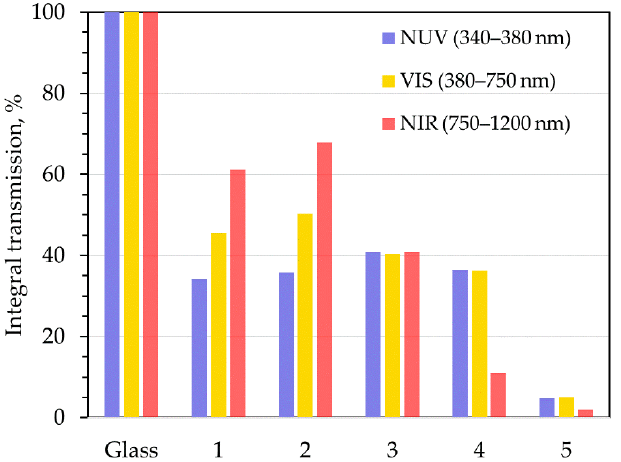
Figure 8. Normalized integral transmission of the valve metals functional thin films. On average, the transmission attenuation for quasi-ordered samples 1–4 in the ranges studied is about 40–60%. The best transmittance is recorded in the NIR range for anodic aluminum films containing a sublayer of tantalum. Such optical properties and the possi- bility of incorporating PAAO-based structures with the luminescent ions by sol–gel syn- thesis and dipping make Al/Ta oxide structures promising for use as IR transparent win- dow materials, emitting devices, transparent radiation converters, and for IR-spectros- copy of catalytic reactions without submersible manipulators. UV attenuation can be use- ful for operation with film organic–inorganic solar cells to slow down their degradation [50–53]. The integration of magnetic nanoparticles into pores of semi-transparent oxide has potential for applications such as electromagnetic interference shielding and magneto- optical storage with cheaper technology, excluding the existing deficiencies of using pol- ymer matrices [54]. The slight improvement of transmission in all wavelength ranges after additional heat treatment at 450 °C for aluminum oxide films on a sublayer of tantalum oxide may be due to the final removal of water and organic compounds from the oxides. The non-ordered PAAO film obtained by anodizing in a mixture of sulfuric and oxalic acids at 20 V shows the worst transmission, associated with the low ordering of the result- ing oxide at the smallest pore sizes ( ≥ 20 nm according to SEM data), which contributes to increased scattering and repeated reflection and absorption of optical radiation in the thickness of the oxide throughout the wavelength range. PAAO with a sublayer of vana- dium oxide is characterized by the uniform transmission of radiation over the entire wave- length range. 4. Conclusions Novel semi-transparent multilayered valve metals oxide coatings on glass substrates, obtained by electrochemical oxidation in potentiostatic mode in the oxalic electrolyte at 60 V from the sputtered Al, V, and Ta thin films were proposed. PAAO was formed by one-step anodizing on Ta or V oxide sublayers in quasi-ordered and non-ordered (in the sulfuric–oxalic electrolyte at 20 V) forms, which was confirmed by SEM analysis. Trans- mission spectroscopy confirmed the main role of the PAAO ordering process in the trans- parent properties of the obtained layered structures. All samples, excluding non-ordered PAAO obtained in the sulfuric–oxalic electrolyte at 20 V, demonstrate semi-transparentness in the range of 300–2800 nm. The refractive index, obtained by the envelope method from transmission spectra, for the sample with